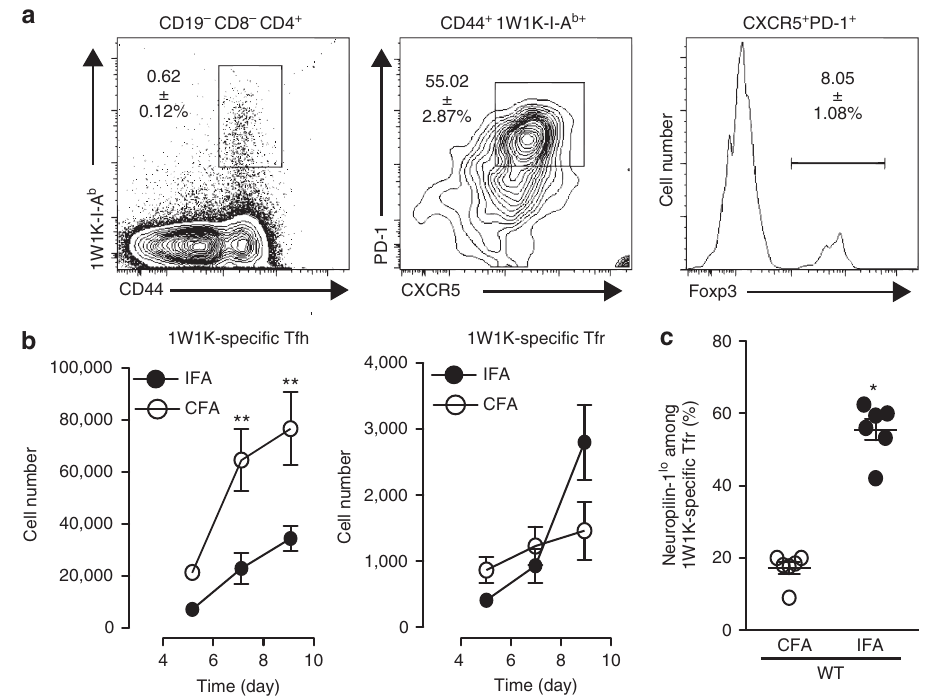
Figure 3 | Immunization with a non-self Ag in IFA induces increased numbers of Tfr. ( a ) WTmice immunized with 1W1K emulsified in CFA or IFA. dLNs were harvested for the detection of 1W1K-specific CD4 þ T cells (CD44 þ 1W1K-I-A b þ ) and follicular cells (CXCR5 þ PD-1 þ ). Tfr cells (1W1K-I-A b þ CXCR5 þ PD-1 þ Foxp3 þ ) were identified within total 1W1K-specific follicular cells. ( b ) Absolute numbers of total 1W1K-specific Tfh cells and Tfr cells over time in dLN after immunization with CFA (open circle) or IFA (solid circle). ( c ) Neuropilin-1 lo expression among 1W1K-specific Tfr cells 7 days after immunization with CFA (white circles) or IFA (black circles). Data are from one experiment of six mice per strain and are representative of three independent experiments. Data were analysed using the non-parametric Mann–Whitney test * P o 0.05, ** P o 0.01, mean ± s.e.m.